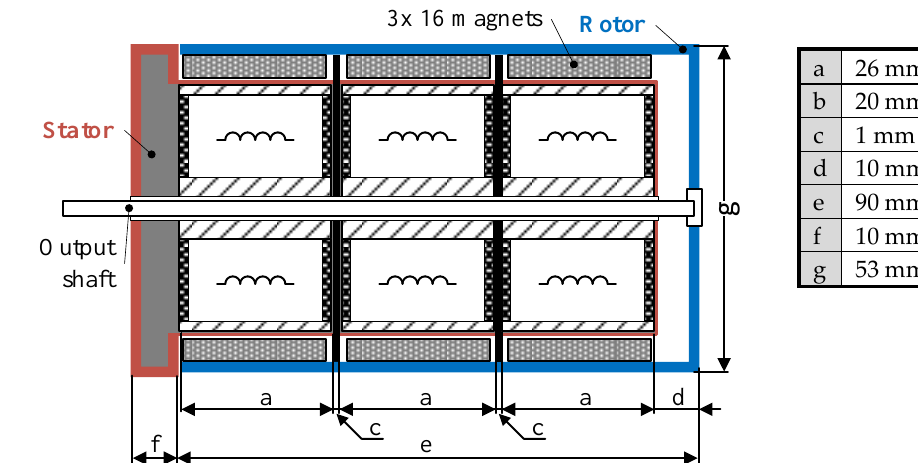
Figure 3. Three-layer BLDC construction layout of the proposed design.